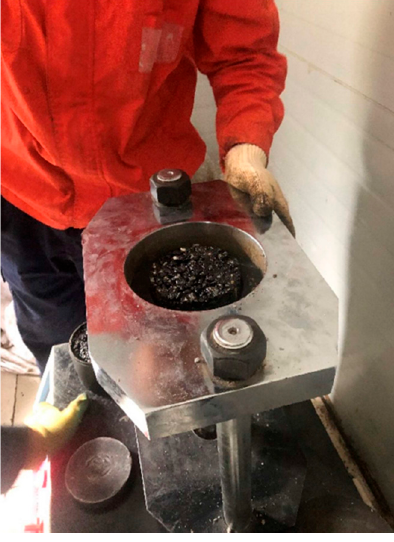
Figure 5. Demoulding process of Marshall test specimens.